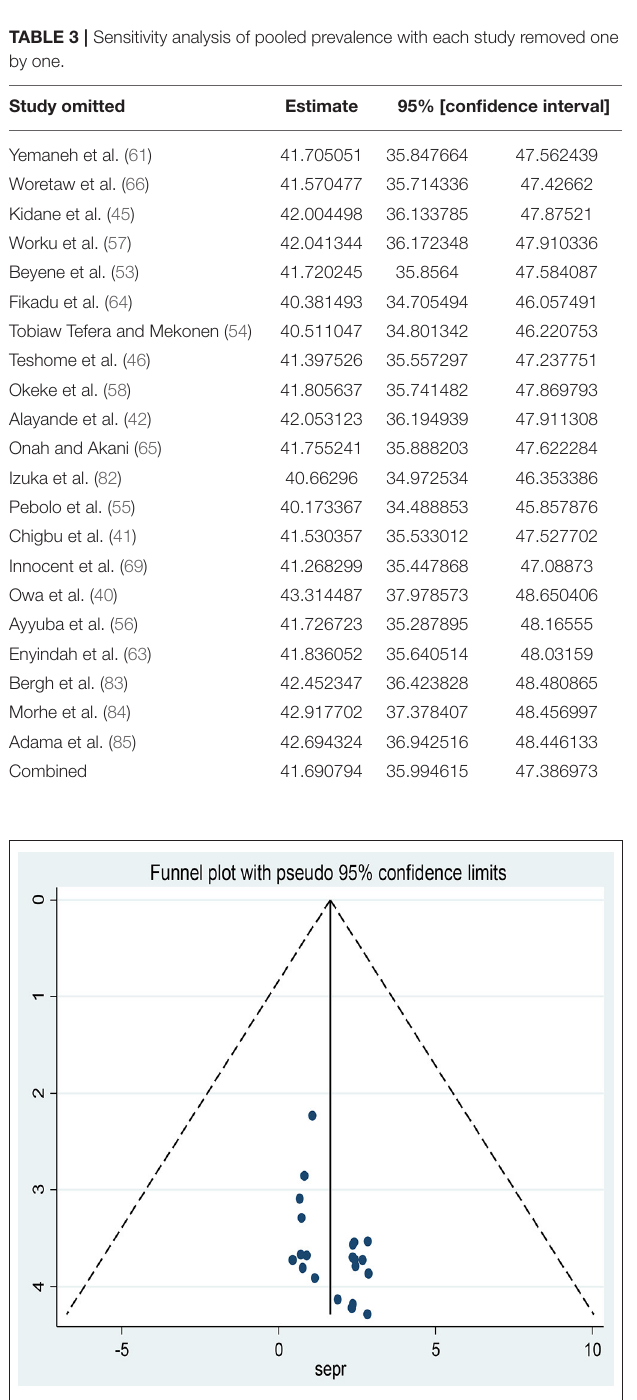
FIGURE 6 | Funnel plots for publication bias for episiotomy practice in Africa,